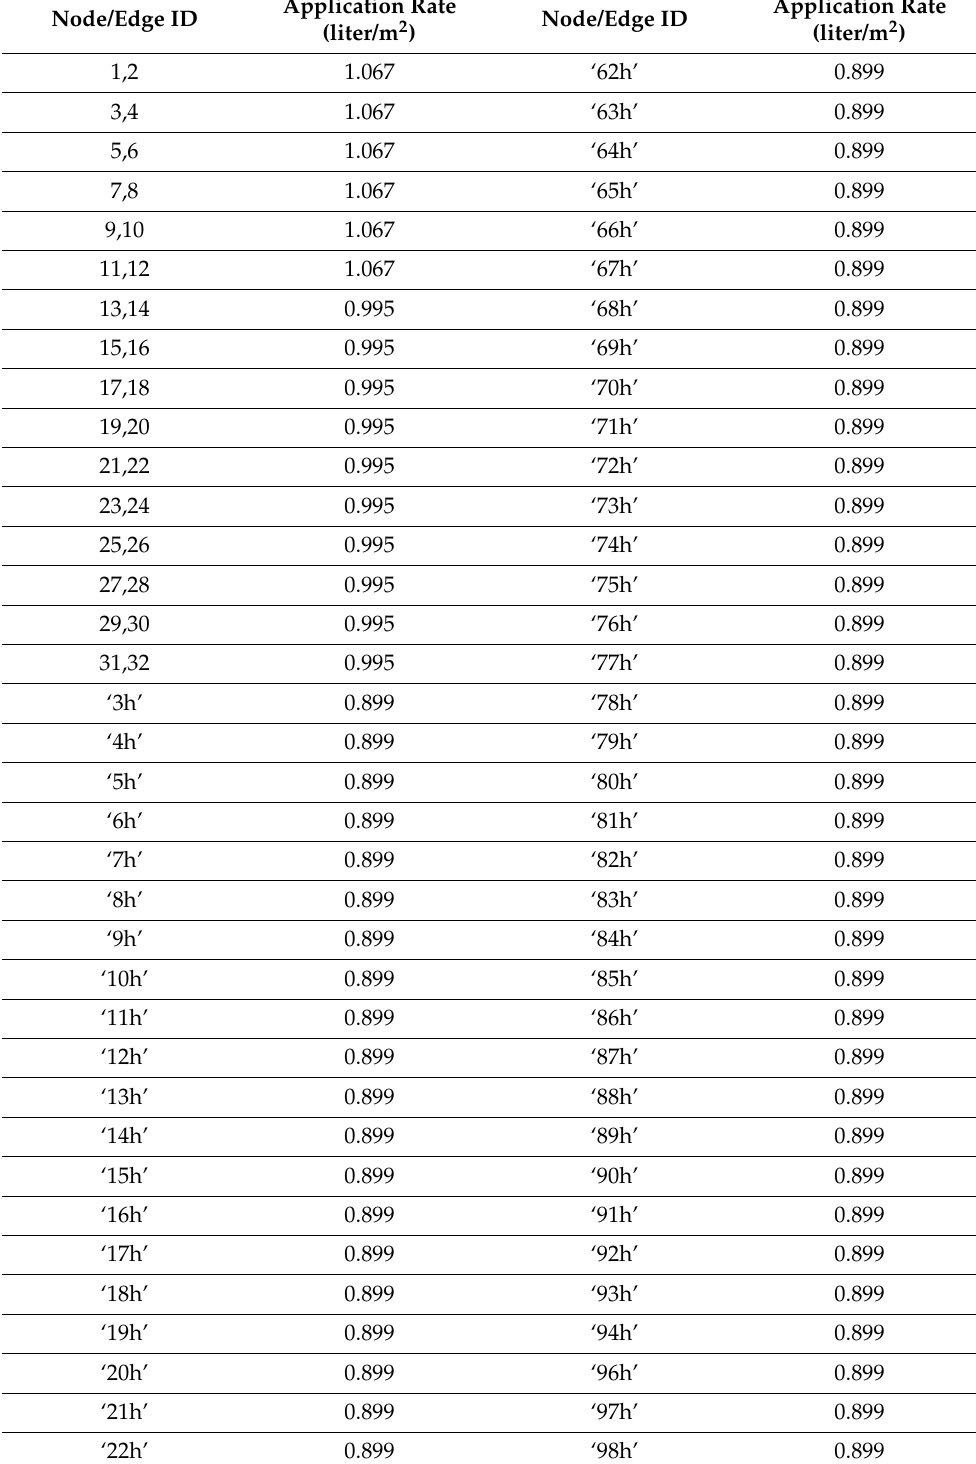
Table A1. The list of application rates for covering the sample field with a normal distributer (capacity 24 m 3